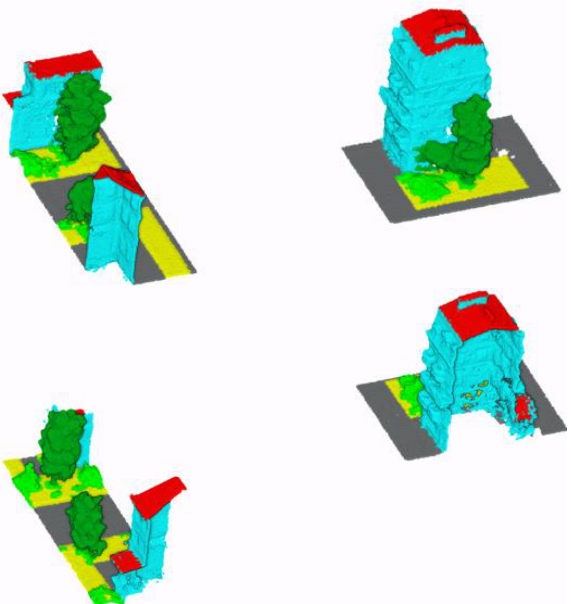
Figure 5. Training set (top) and evaluation set (bottom) for 6 classes: ground (grey), grass (yellow), shrub (light green), tree (dark green), facades (cyan), roof